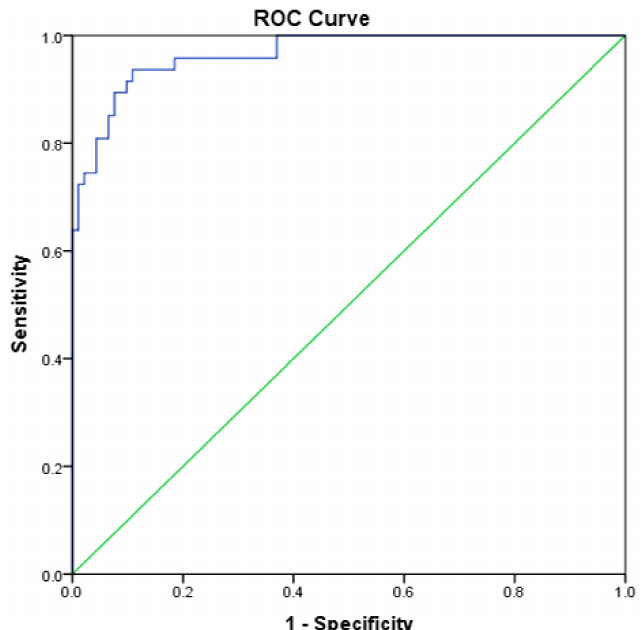
Figure 2. The ROC curve for discriminating α from β -thalassaemia traits generated from the αβ -algorithm.